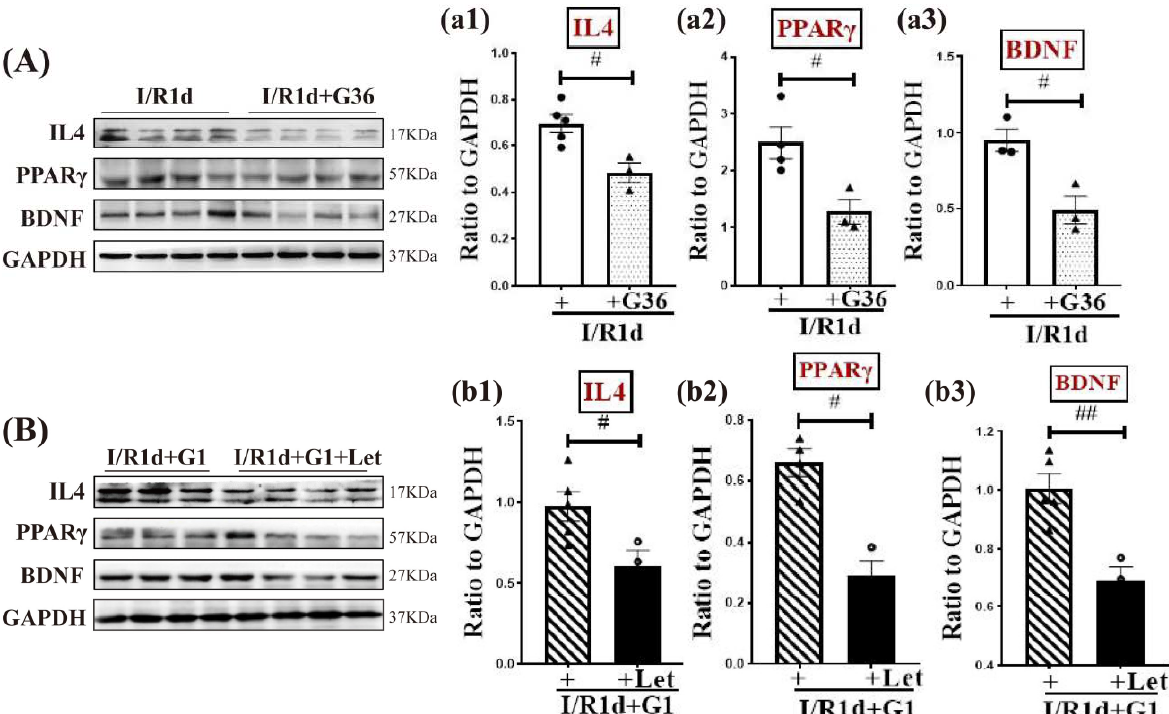
Figure 6. Synergistic action of G1 and BDE2 promoted microglial polarization to the M2 phenotype after 1 day of reperfusion in the ovariectomized rat hippocampal CA1 region. ( A , B ) Representative bands of Western blot analysis of IL4, PPAR γ , and BDNF in the indicated groups. GAPDH was used as the loading control. Quantification of blots is depicted in ( a1 – a3 ) and ( b1 – b3 ). Data are expressed as ratios to GAPDH (means ± SEs, n = 3–5 in each group). # p < 0.05 and ## p < 0.01. BDE2, brain ‐ derived estrogen; IL, Interleukin; BDNF, Brain ‐ derived neurotrophic factor.